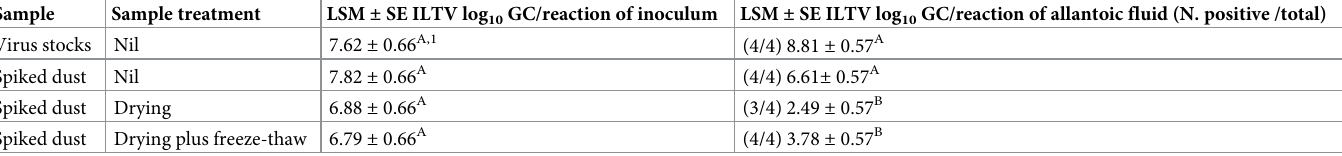
Table 2. Experiment EGG-2. ILTV log 10 GC in the inoculum and allantoic fluid of eggs inoculated with virus stock or an equivalent amount of stock spiked on dust sam- ples subjected or not to drying at 30˚C for 24 h and two freeze-thaw cycles. Sample